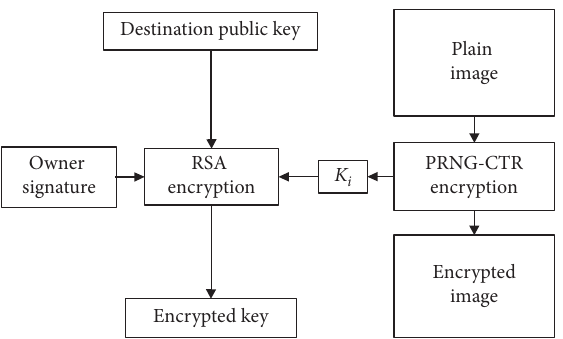
Figure 1: General view of the proposed encryption